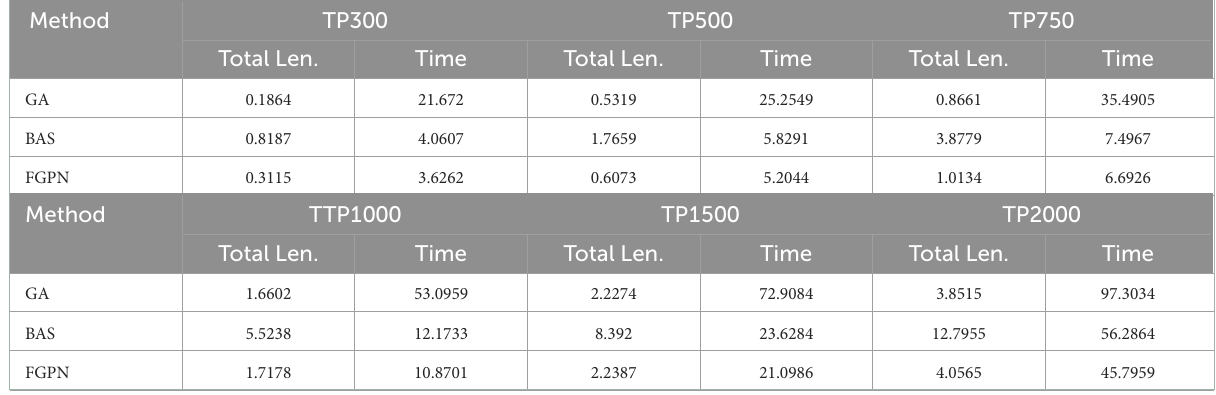
TABLE 3 The relationship between the solution time and the total moving distance and the scale of the task nodes when the number of target task nodes in the task cluster is about 50. The unit of total Len. in the table is 10 6 m , and the unit of Time is seconds. Method